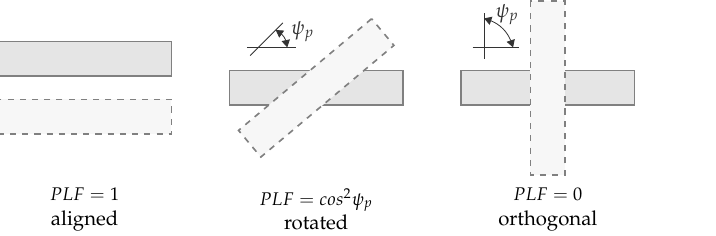
Figure 21. Transmitting and receiving antennas PLF visualization example (similar for linear wire antennas), based on